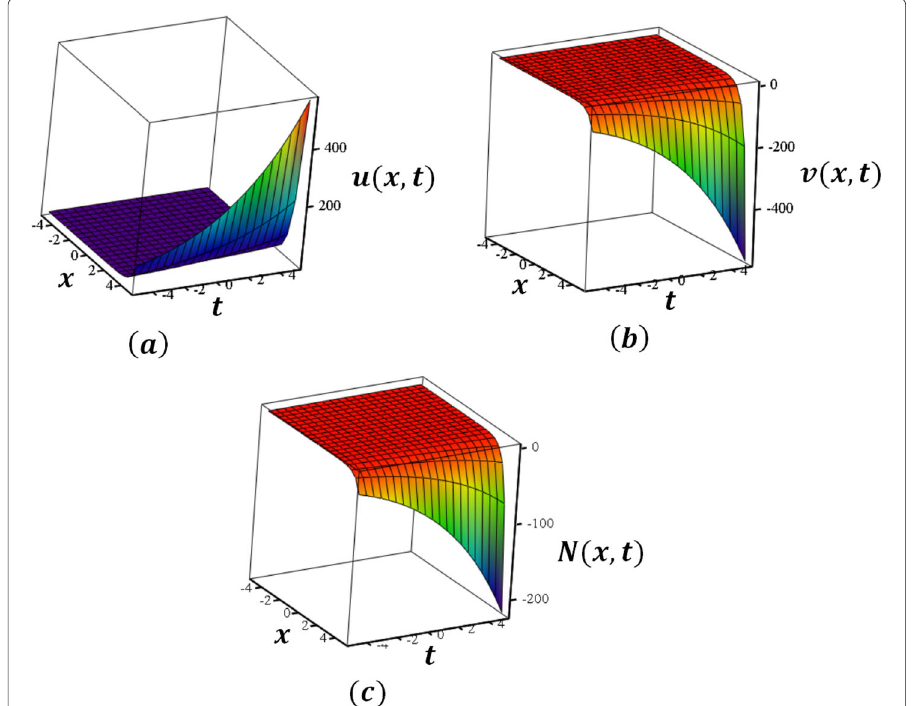
Fig. 4 3D profiles of the velocity field u ( x , t ) , v ( x , t ) , and microrotation N ( x , t ) for MHD micropolar fluid given by Eqs. (32), (33), and (34), for U = 0.1, ν = 0.045, μ = 0.5, κ = 0.2, B 0 = 2, k ∗ = 0.2, σ = 0.2, j = 0.03, m = n = 1, y = 1, c 0 =